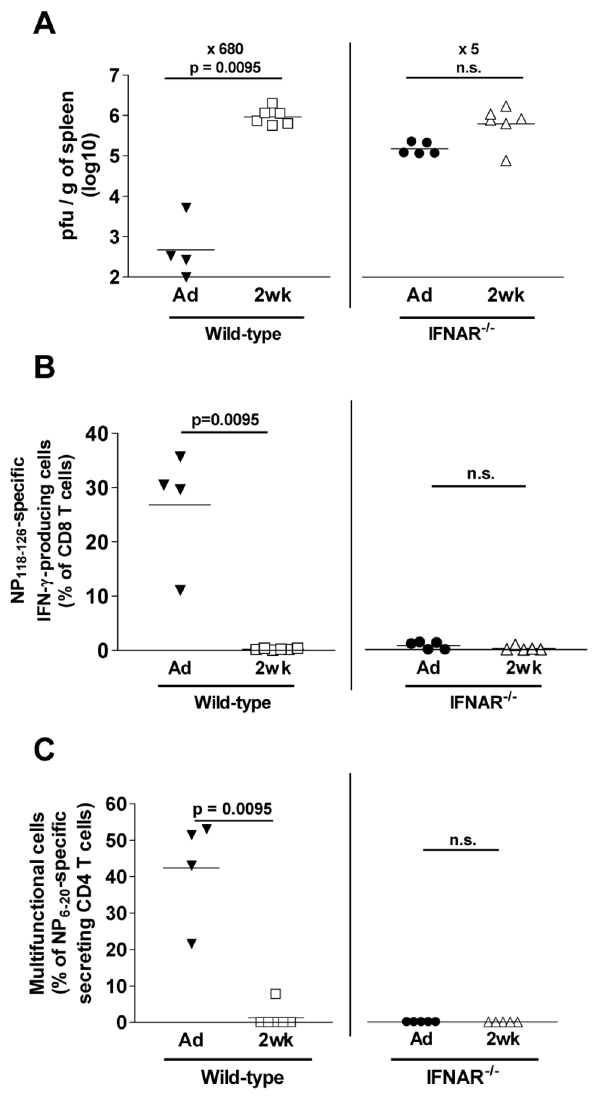
Figure 2. Similarly impaired viral control and T cell responses in infant WT as in adult/infant IFNAR -/- mice. 2- week-old and adult WT or IFNAR -/- mice were infected i.v. with 100 pfu of LCMV-WE and assessed 10 days later. (A) Spleen viral titers. One of two representative experiments is shown. The fold difference in viral titers between adult and infant WT (x 680) or IFNAR-/- (x 5) mice is indicated. (B) Percentage of LCMVnp118-126-specific IFN-γ producing CD8 + T cells. Percentages obtained in medium controls were subtracted. One of two representative experiments is shown. (C) % of LCMVnp6-20-specific IFN-γ, IL-2 and TNF-α secreting CD44 + CD4 + T cells. Percentages obtained in medium controls were subtracted. One of two representative experiments is shown.